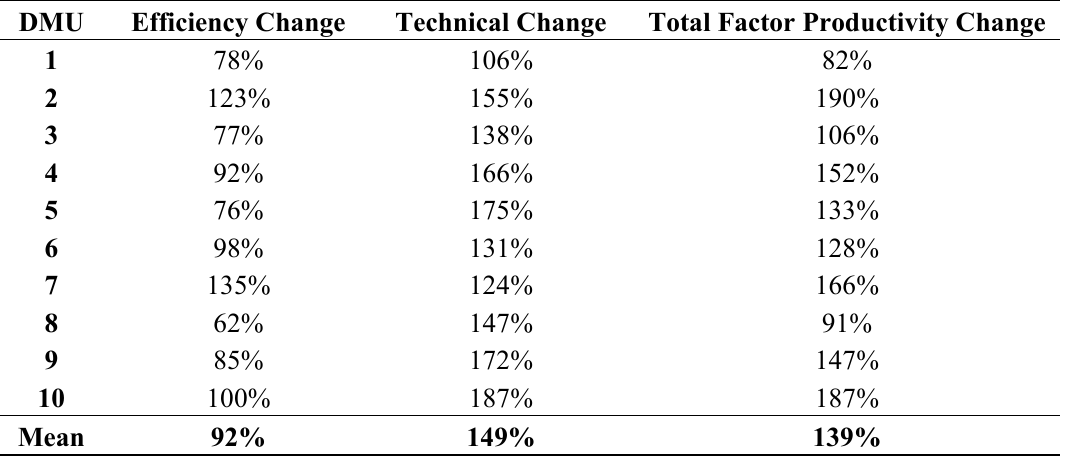
Table 6. Malmquist index summary